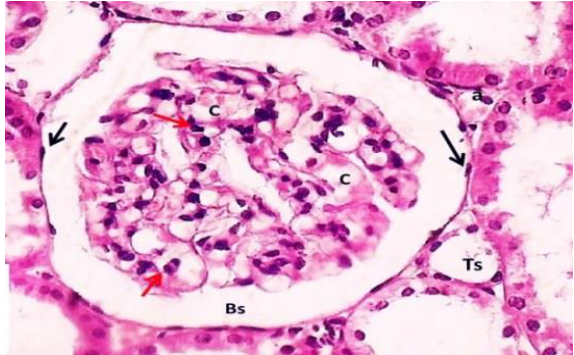
Figure, 7: Histological section of nephron (glomerulus) shows: Capillaries (C), squamous epithelium of parietal layer (Black arrows), visceral layer forming podocytes (Red arrow), bowman space (Bs) and thin segment of loop of henle (Ts). H&E stain. 400x.